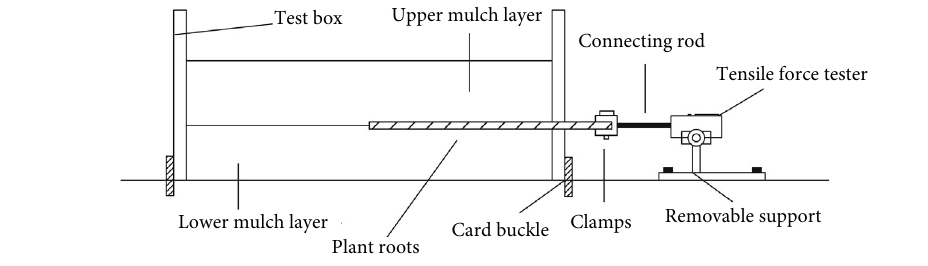
Figure 5: Root pulling test device.